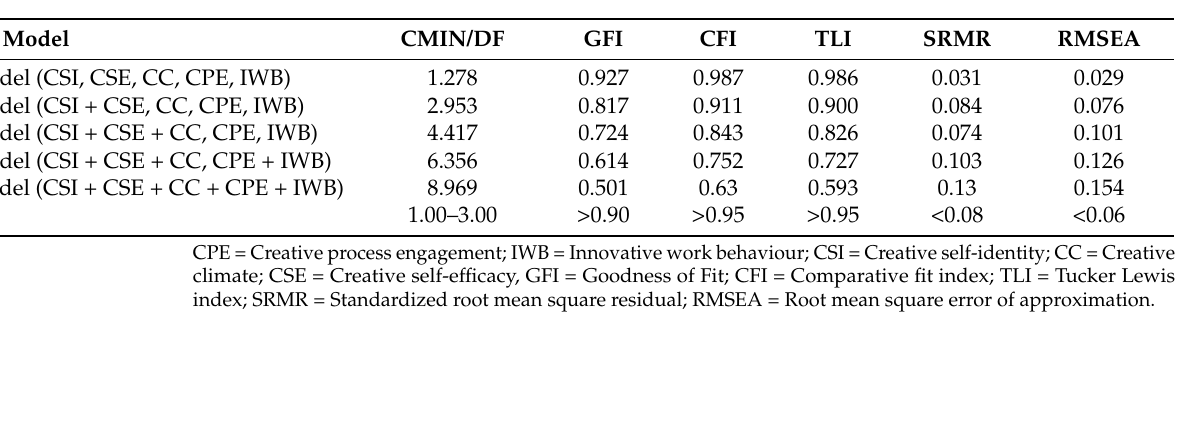
Table 2. Alternative model